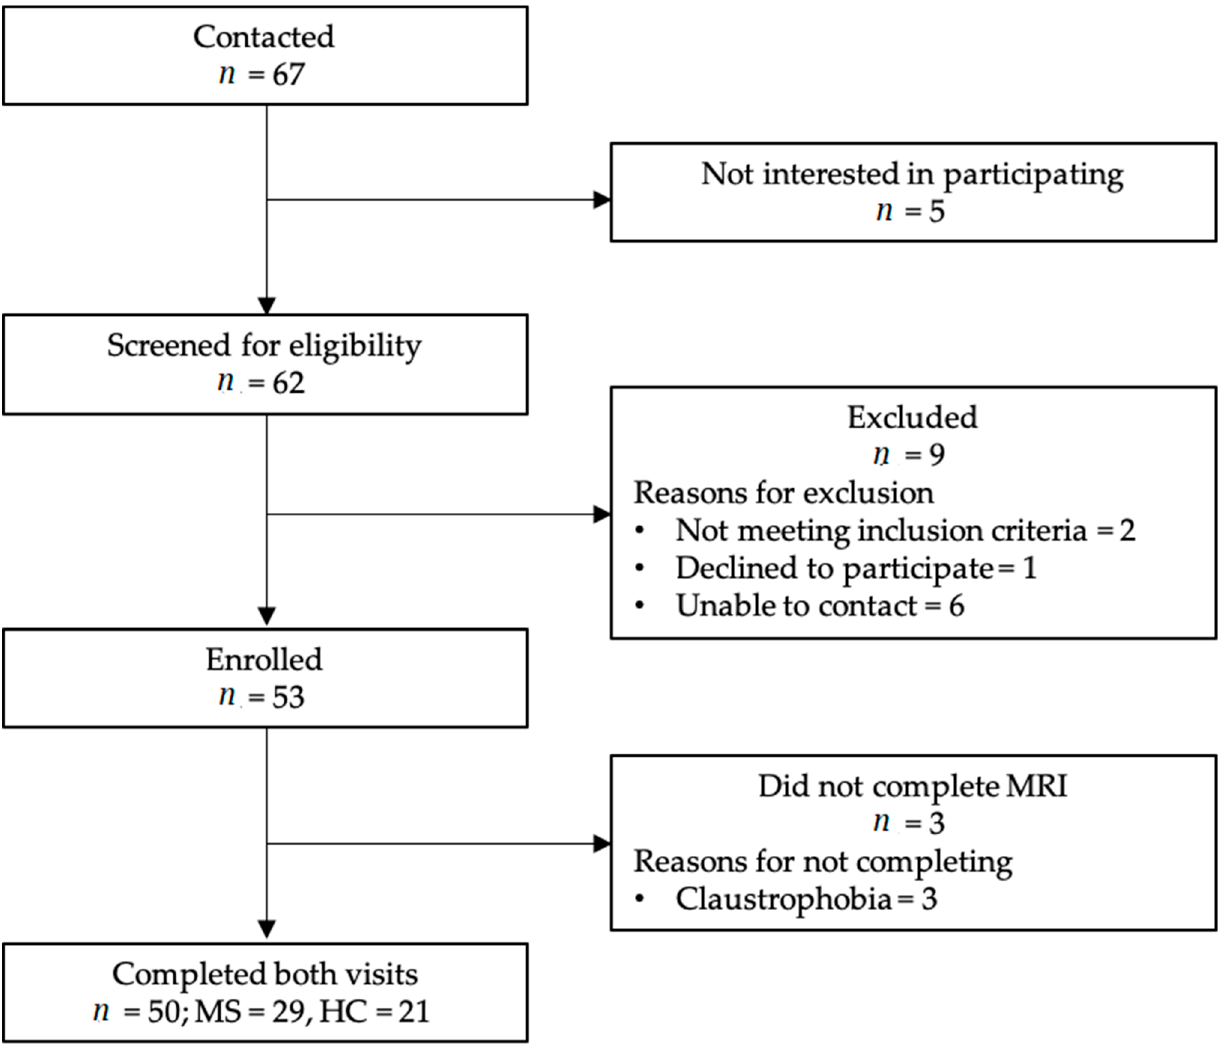
Figure 1. The flow of participants through the recruitment and enrollment process. Three individuals (2 MS, 1 HC) were unable to complete the MRI and, therefore, were excluded from any MRI-related analyses. MS = multiple sclerosis; HC = healthy control.